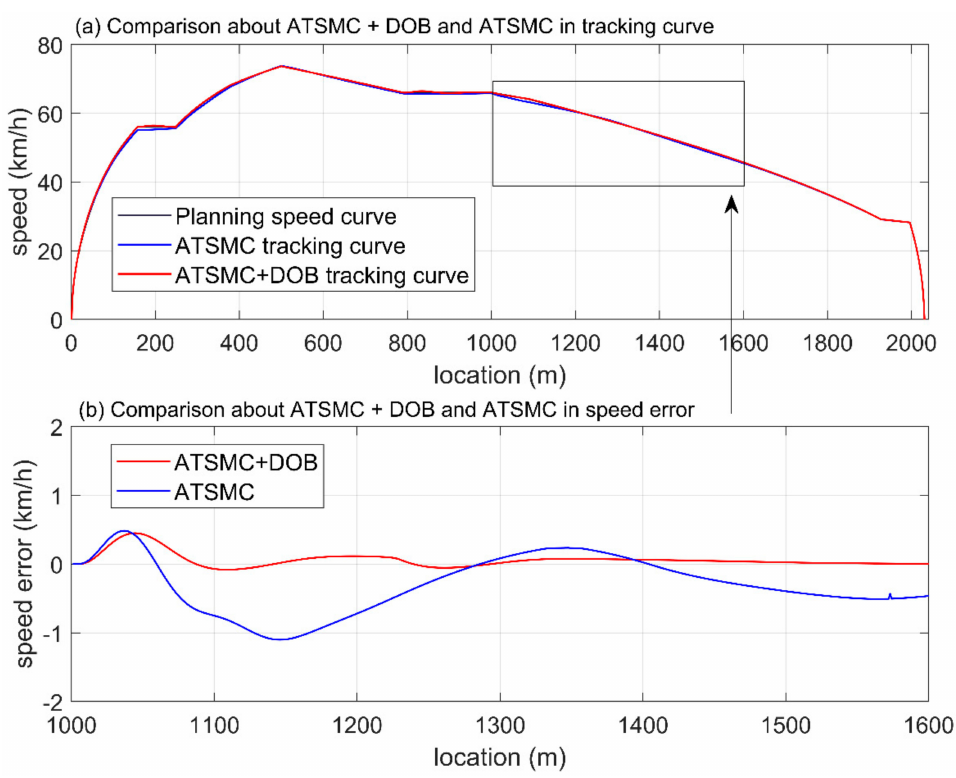
Figure 21. Comparison of energy consumption of di ff erent